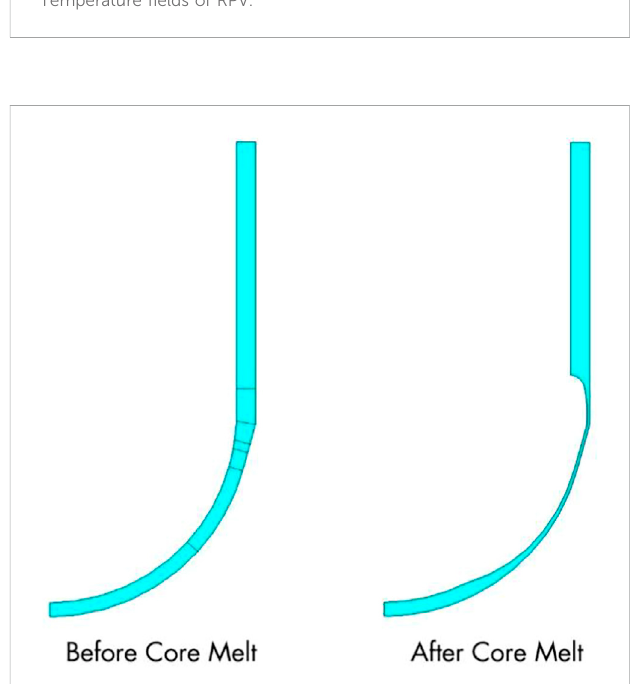
FIGURE 9 Temperature fi elds of RPV.